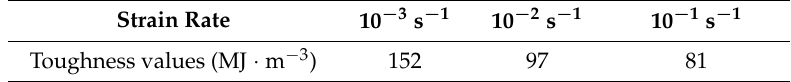
Table 2. Toughness values of Gum Metal determined during tension at three strain